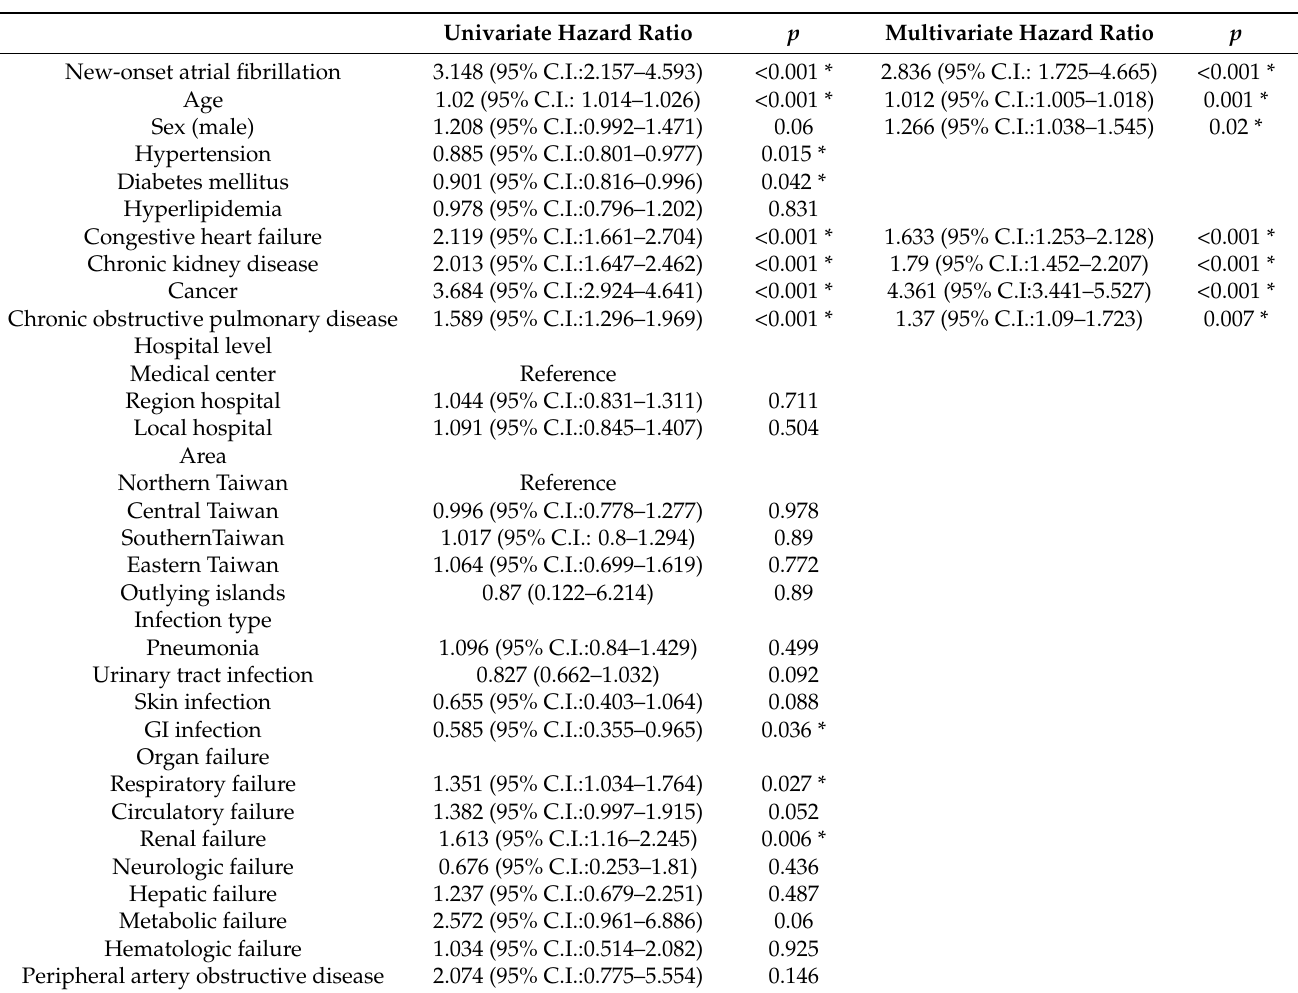
Table 3. Risk factors for ischemic heart disease in septicemia survivors.